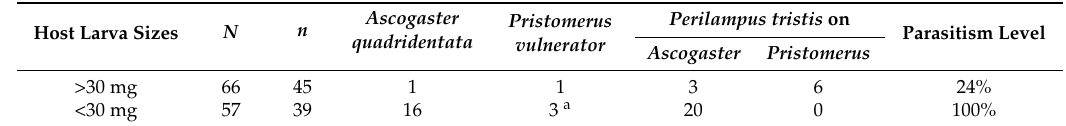
Table 4. Distribution of the parasitoids that emerged from codling moth larvae collected in an apple orchard (traditional method). N and n respectively indicate (i) the number of codling moth larvae and (ii) the number of emerging moths and parasitoids that were analyzed for two classes of caterpillar sizes. Estimates of the parasitism levels correspond to the ratio of the number of emerging parasitoid on n .